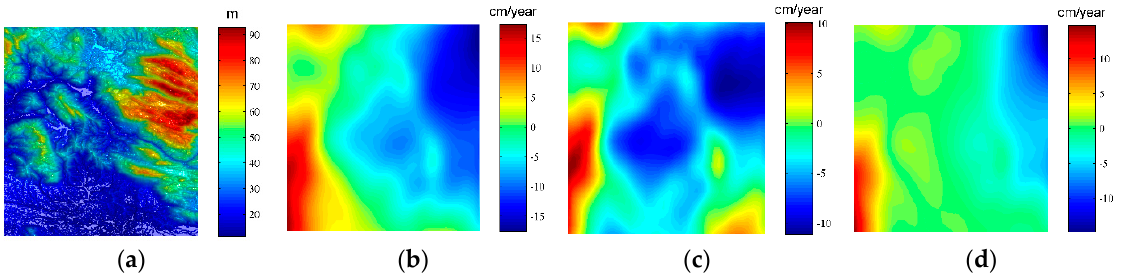
Figure 8. The terrain and the simulation of the deformation maps: ( a ) digital elevation model (DEM) data from SRTM. ( b ), ( c ), and ( d ) are the simulated deformation velocity maps in slant range, azimuth, and elevation direction, respectively.